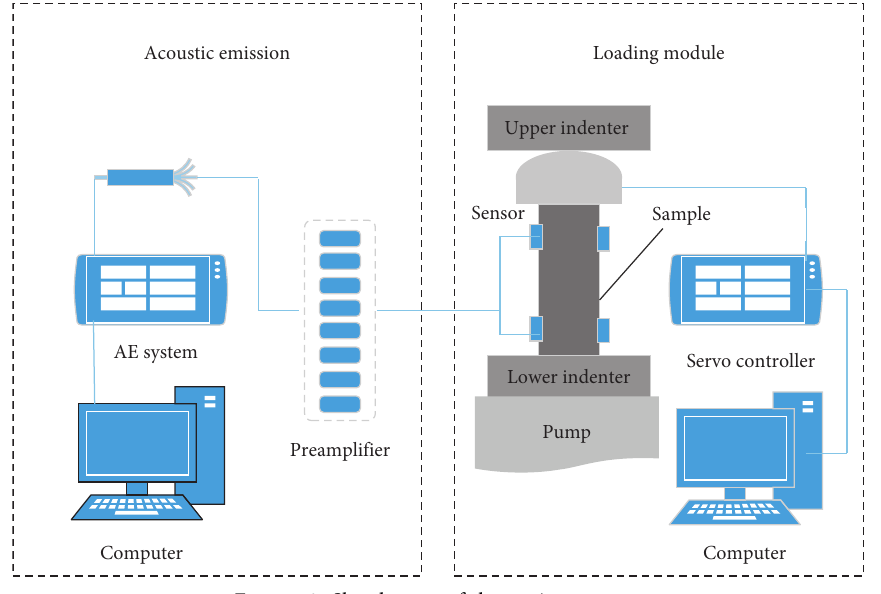
Figure 2: Sketch map of the testing